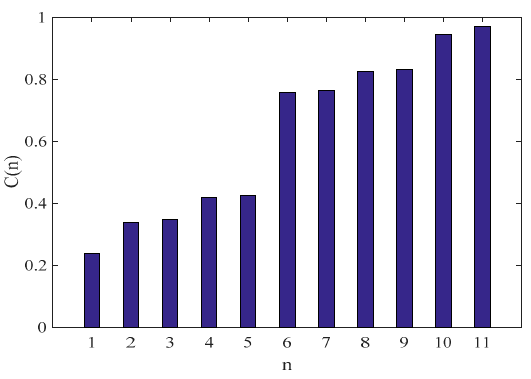
Figure 4. Variation tendency of the correlation coefficient ratio.